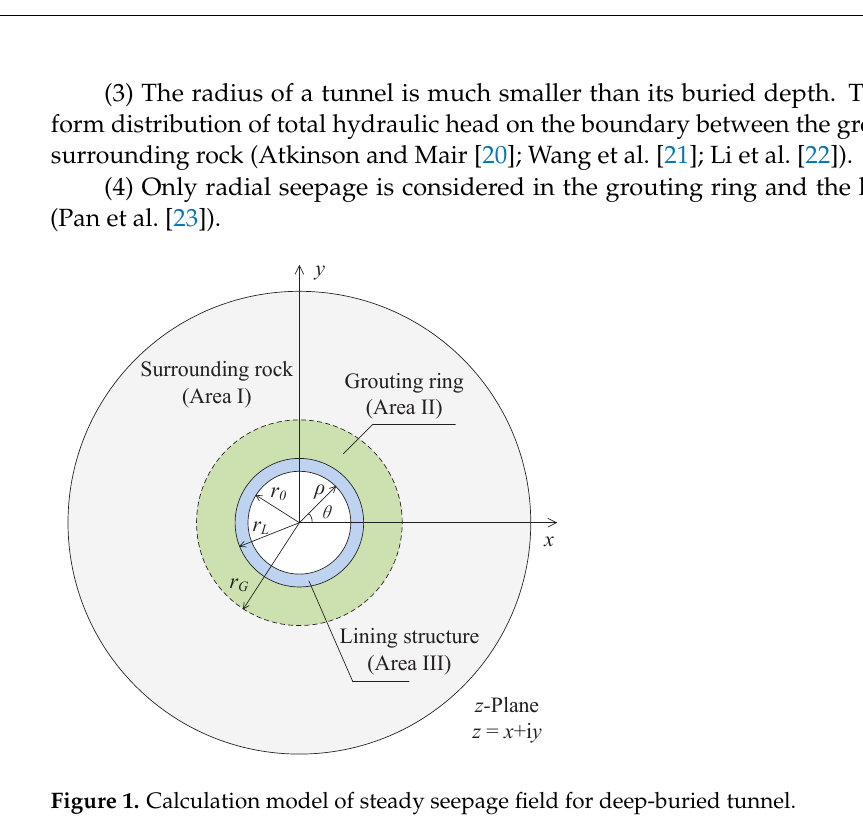
Figure 1. Calculation model of steady seepage field for deep-buried